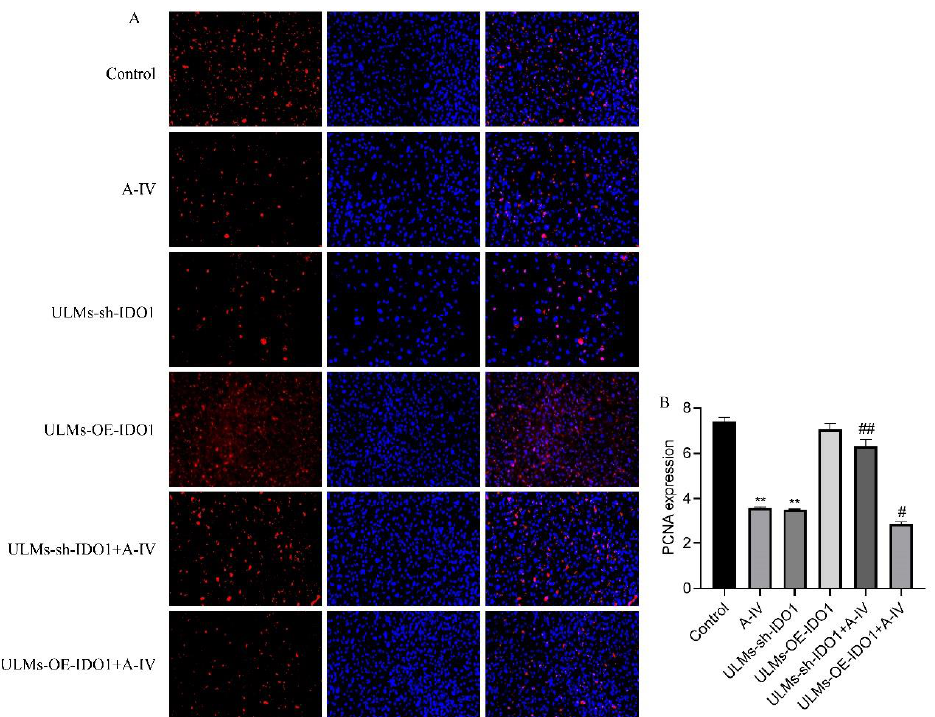
Figure 4. Immunofluorescence analysis shows the effect of proliferation in ULM cells after transfection with shRNA-IDO1 by AS-IV. ( A ) PCNA protein expression under fluorescence microscopy. ( B ) ImageJ was used to calculate positive fluorescence density. The data are presented as the mean ± SD ( ** p < 0.01 compared with the control group; # p < 0.05, ## p < 0.01 compared with the A-IV group). 3.4. IDO1 Involved in the Apoptosis Induced by AS-IV in ULM Cells To elucidate the potential mechanism by which IDO1 is involved in the inhibitory effect of AS-IV in ULM cells, we performed a flow cytometry assay. Compared with the AS-IV-only group, the ULM-sh-IDO1+A-IV group exhibited a significant decrease in the apoptosis rate (Figure 5). These results indicate that IDO1 may be involved in the inhibi- tory effect of AS-IV in ULM cells by modulating apoptosis.